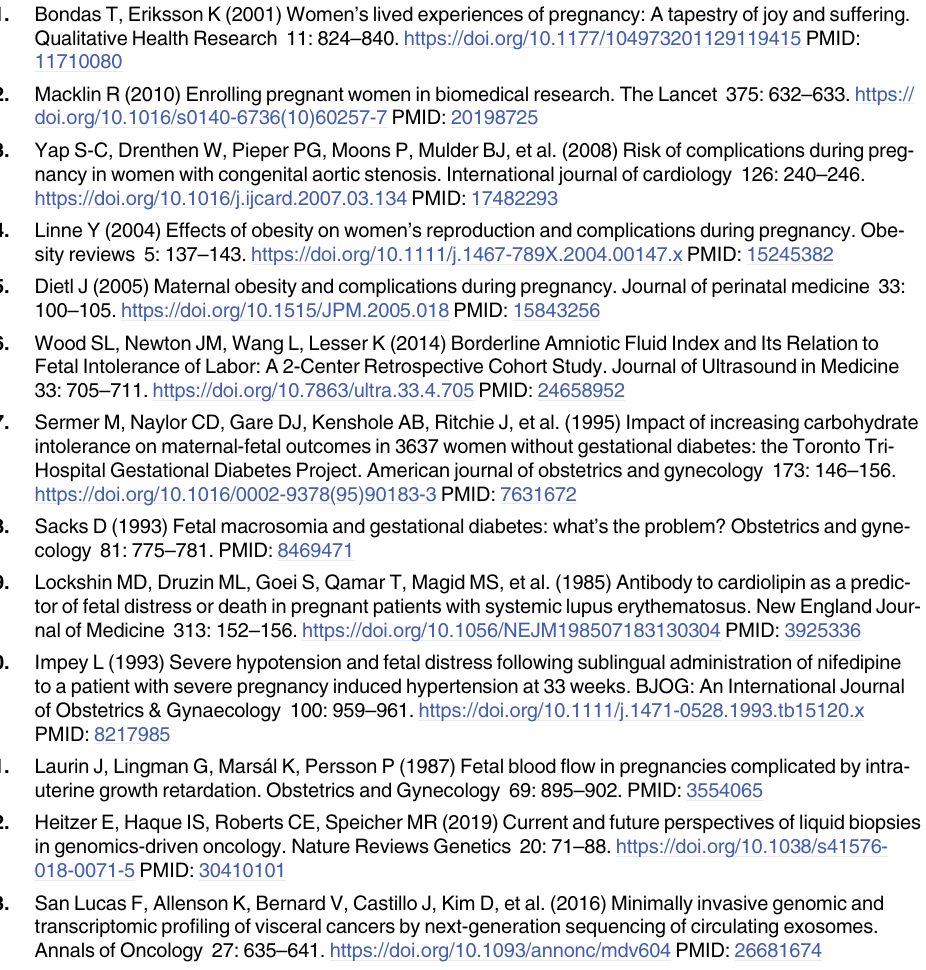
S1 Table. List of ranked features on the basis of